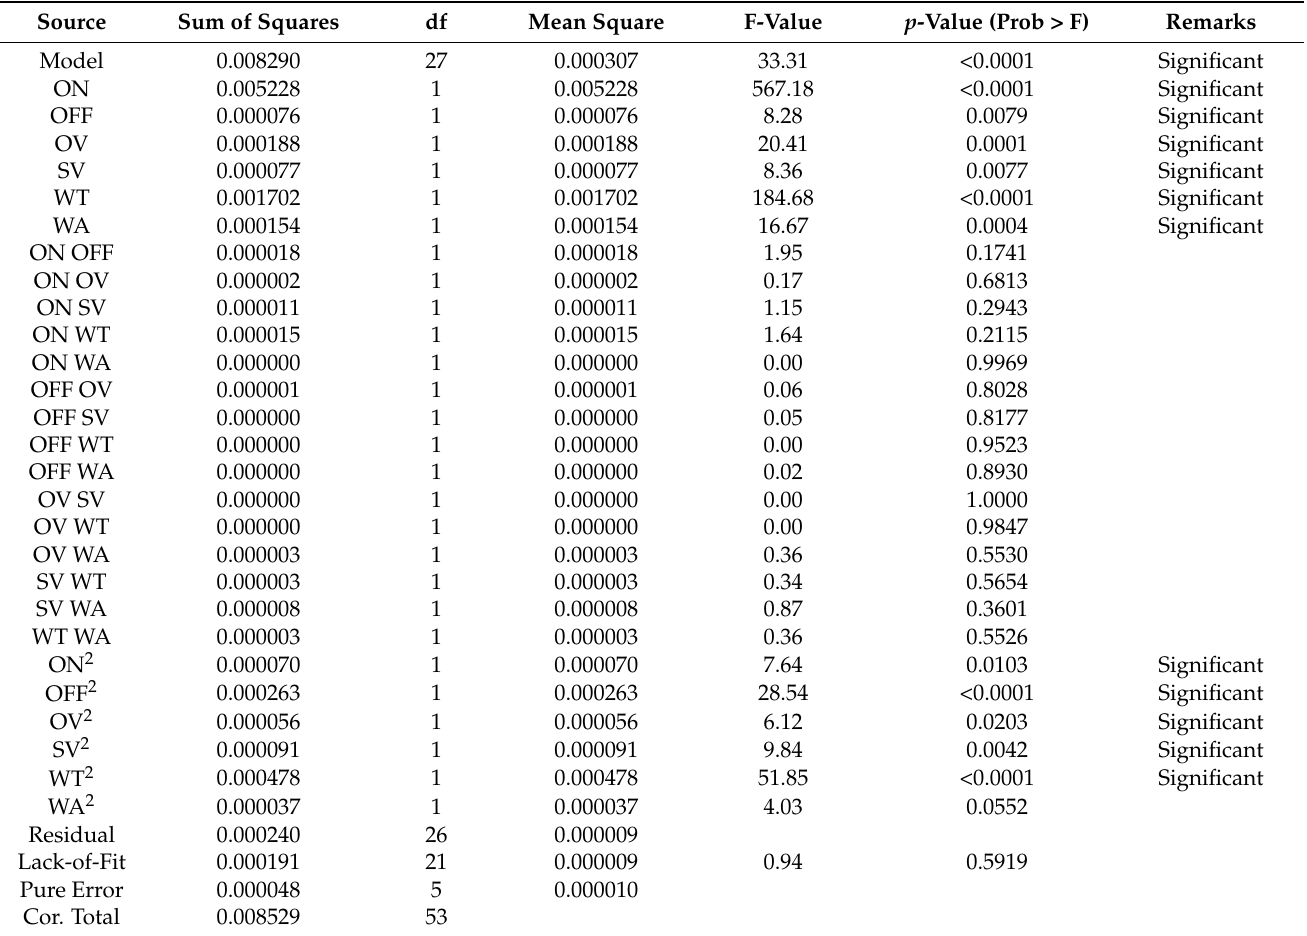
Table 3. ANOVA results of quadratic response surface model for 30 ◦